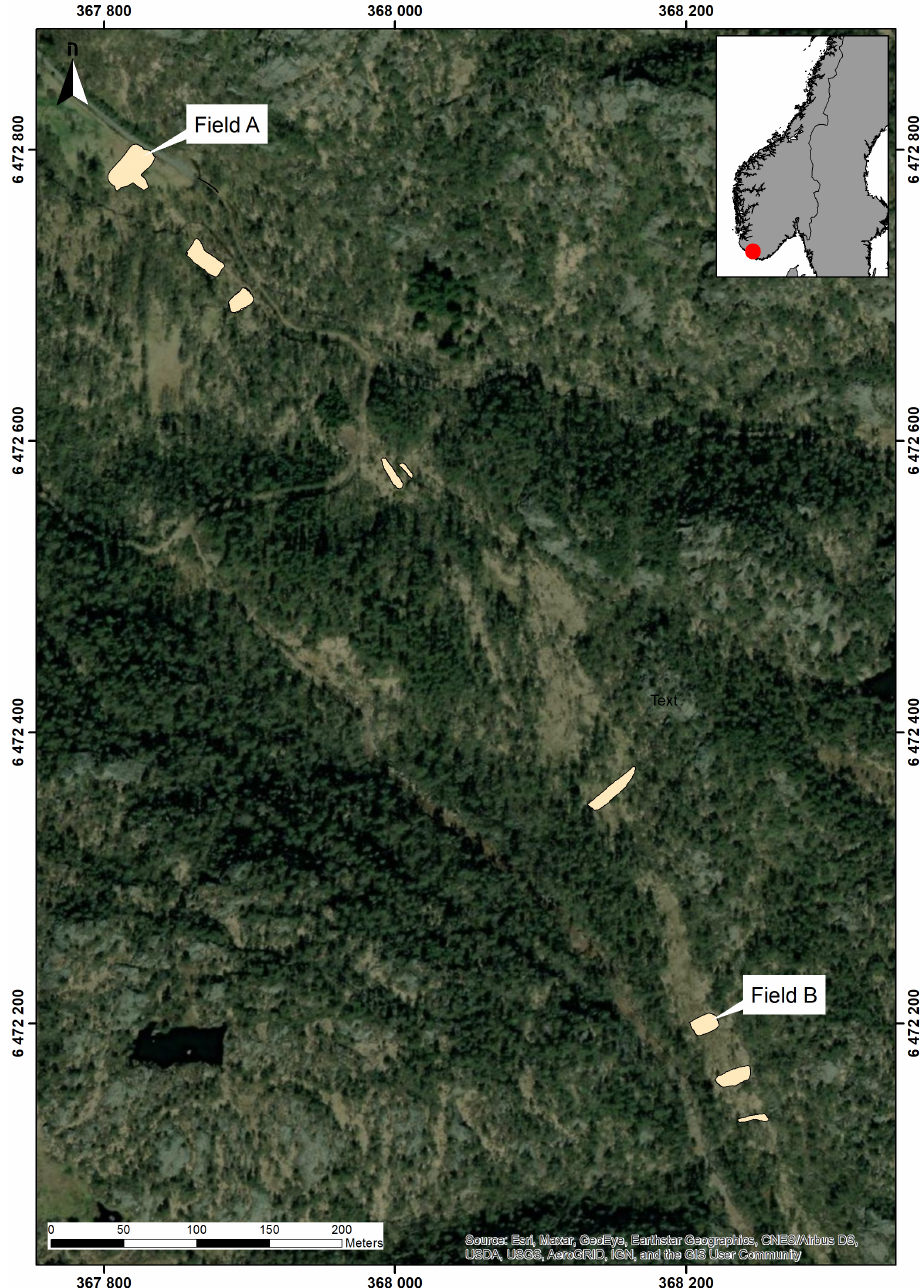
Figure 3. Overview of the bog-areas that have been investigated with GPR at Gausdal (marked in beige). Fields A and B showed positive prospection anomalies that are described in detail in this article. Coordinates are in ETRS 1989 UTM